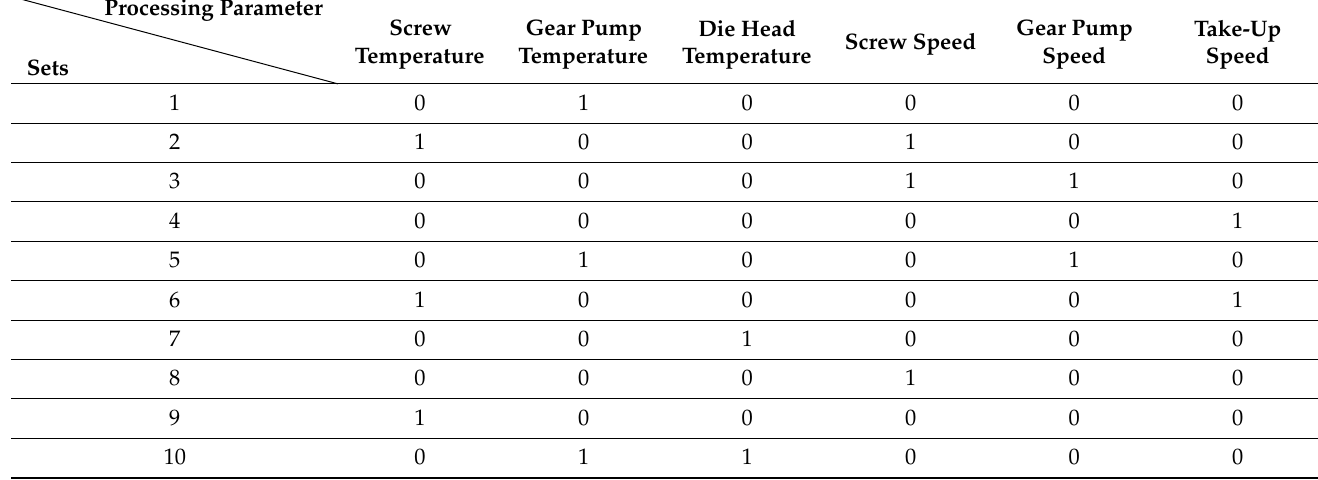
Table 10. Classification results for the corresponding abnormal samples of Table